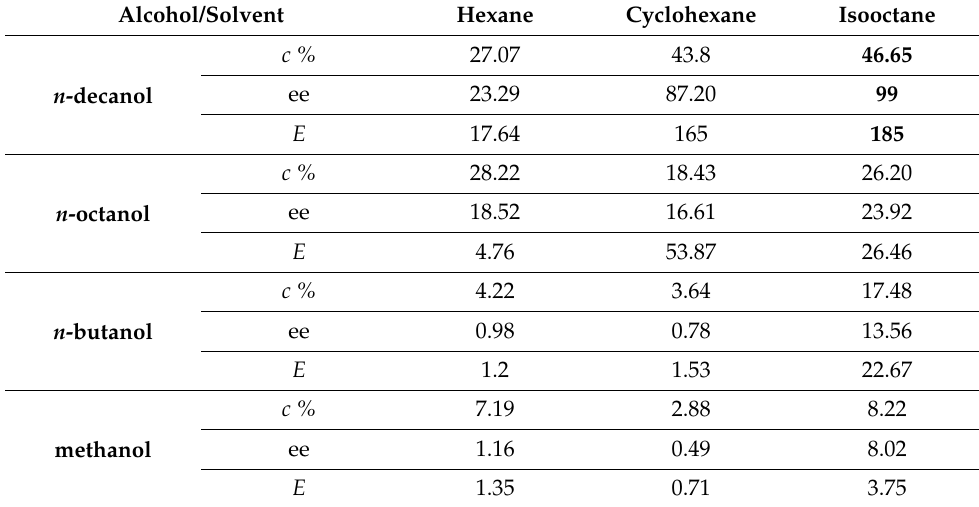
Table 2. Alcohol and solvent experimental determination for the resolution of ( S